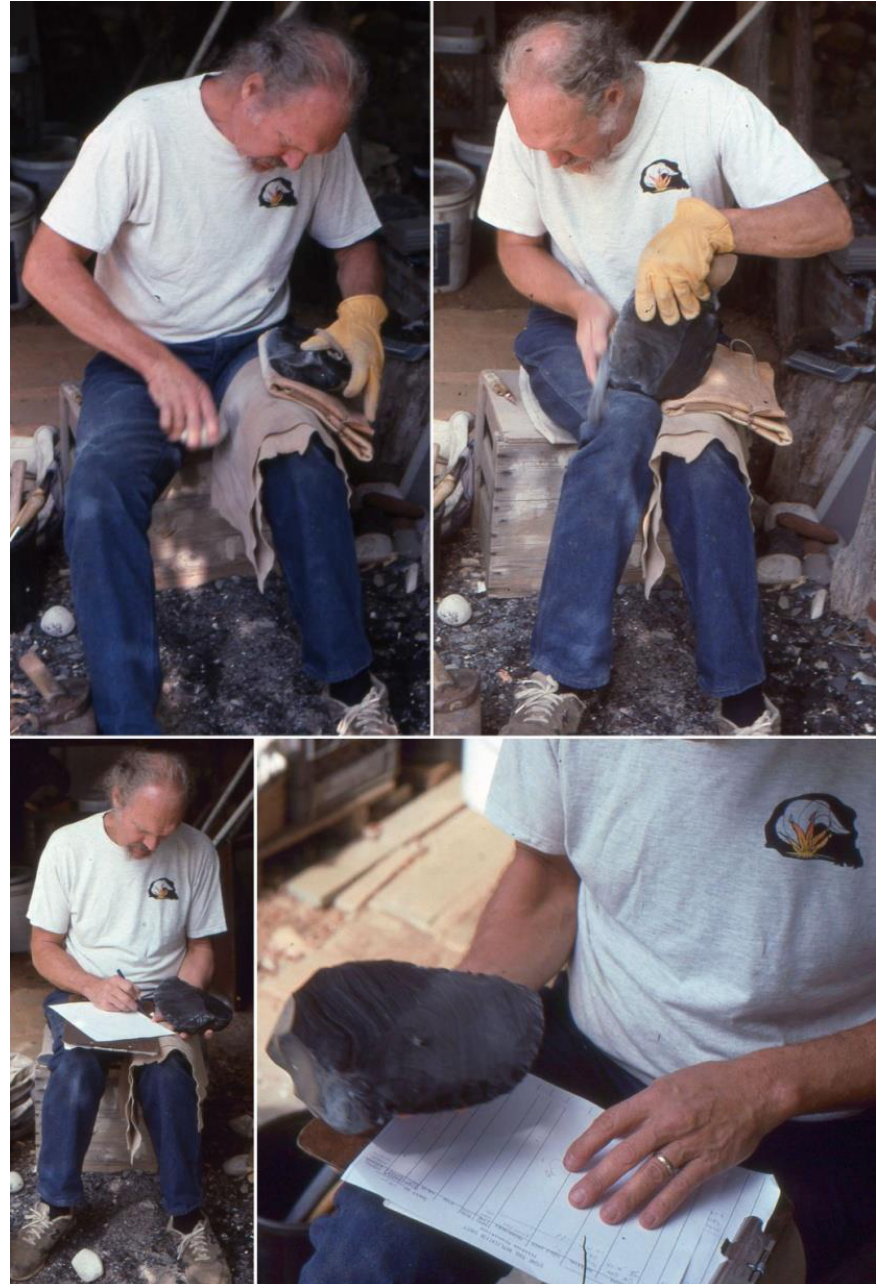
Figure 2. Errett showing the initial manufacturing stages of a Type IV Danish dagger and documentation of his work in 1995. (Photos by H. G.